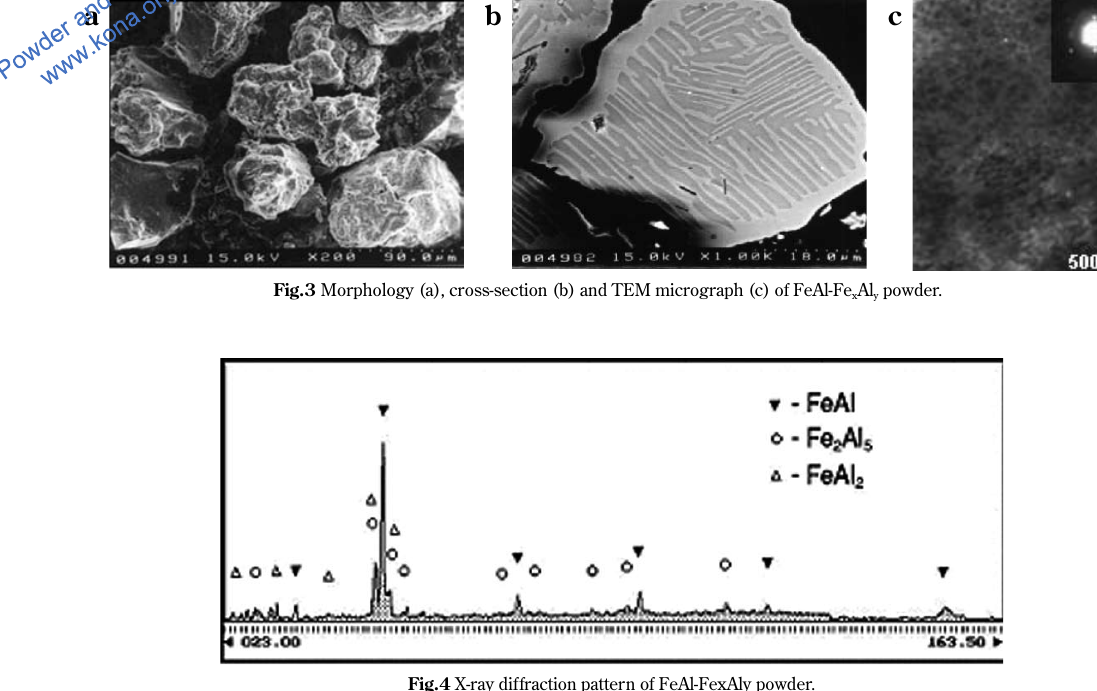
Fig.4 X-ray diffraction pattern of FeAl-FexAly